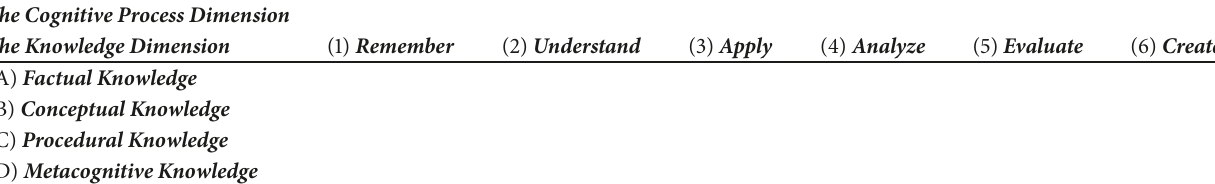
Table 1: Taxonomy Table.